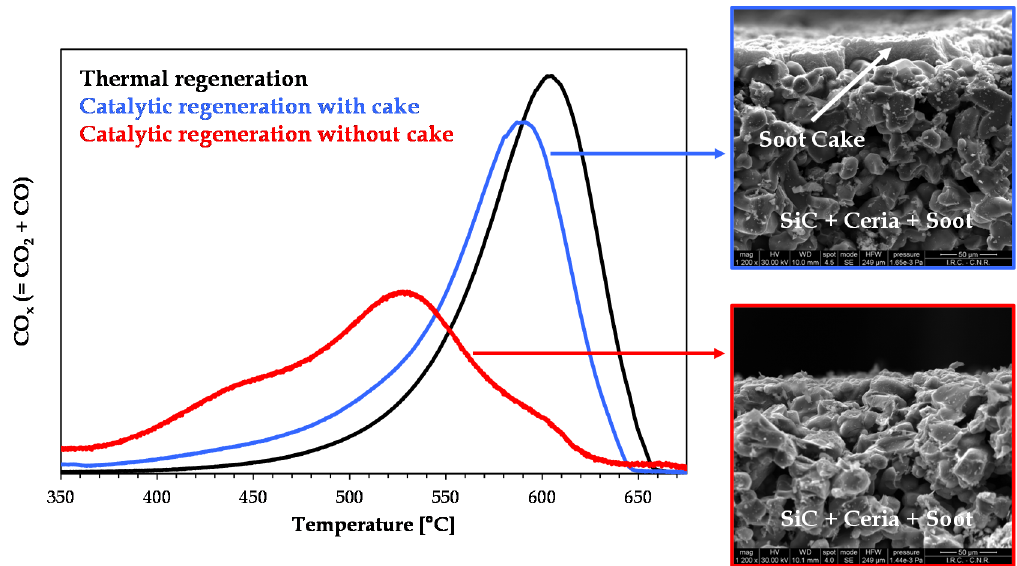
Figure 6. Concentration of CO x (= CO 2 + CO) as a function of filter temperature: thermal regeneration; catalytic regeneration with cake; catalytic regeneration without cake. From [15].